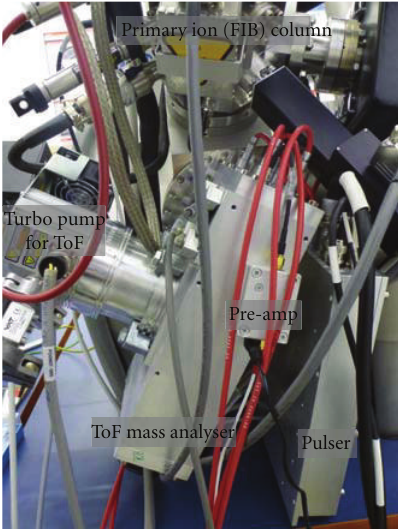
Figure 1: A closer look at the mass analyser in position on the back of the chamber; there is very little space available. The turbo pump on the mass analyser (to protect the detector) will be replaced by an ion pump. The pulser electronics for the orthogonal extraction are placed close to the mass analyser in order to preserve the pulse